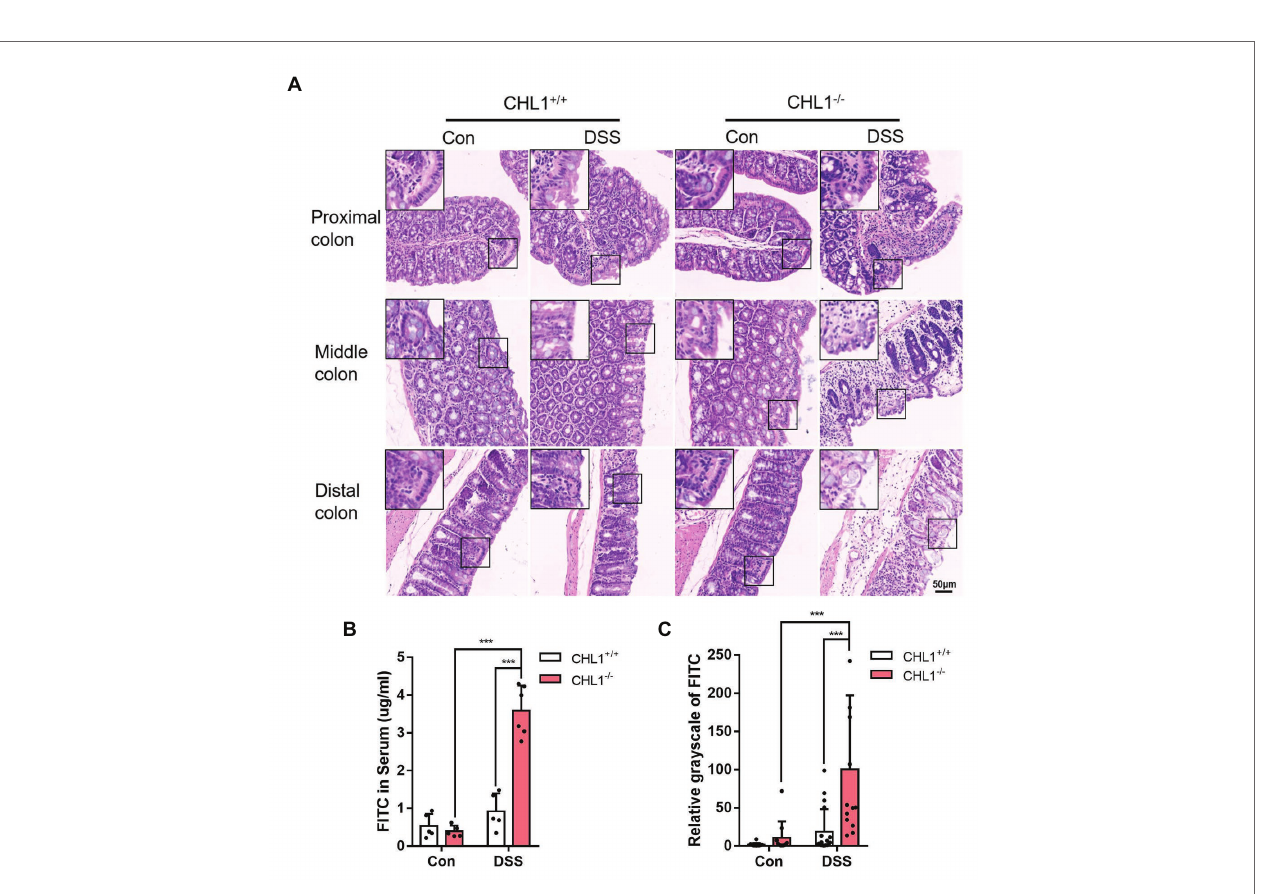
FIGURE 3 | CHL1 deficiency exacerbated epithelial barrier damage in inflammatory bowel disease (IBD). (A) High magnification histological images of colonic tissue from CHL1 +/+ and CHL1 −/− mice with and without DSS treatment showed altered intestinal epithelial cellular shape in tissues from CHL1 −/− animals. Insets show examples of areas of the epithelium under ultrahigh magnification. (B) Intestinal permeability was measured by the appearance of orally administered FITC-labeled dextran in the serum of DSS-exposed CHL1 +/+ and CHL1 −/− mice (*** p < 0.001, n = 5/group). (C) The relative grayscale values of fluorescence microscopy images of the intestinal mucosa from DSS-treated CHL1 +/+ and CHL1 −/− mice exposed to orally administered FITC-labeled dextran (*** p < 0.001, n = 5/group).